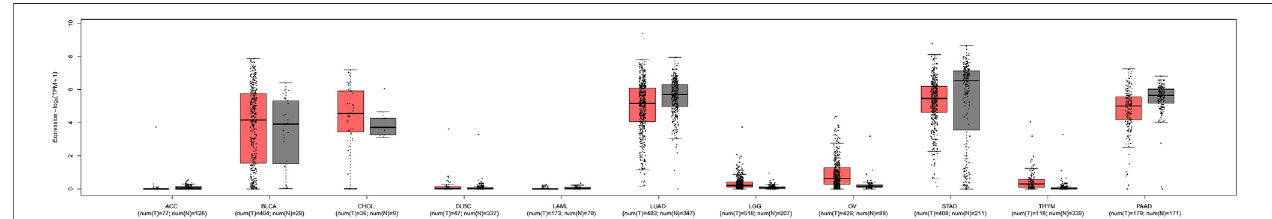
FIGURE5| MutationsofTMPRSS2indifferenttumors. (A) ThemutationsiteofTMPRSS2isdisplayedintheplotbasedonTCGAdatabasefromcBioPortal. (B) 3D structureofTMPRSS2andthemutationsiteinTCGA. (C) ThemutationsiteofTMPRSS2isdisplayedintheplotbasedonthemixedpan-cancercohortfromcBioPortal.